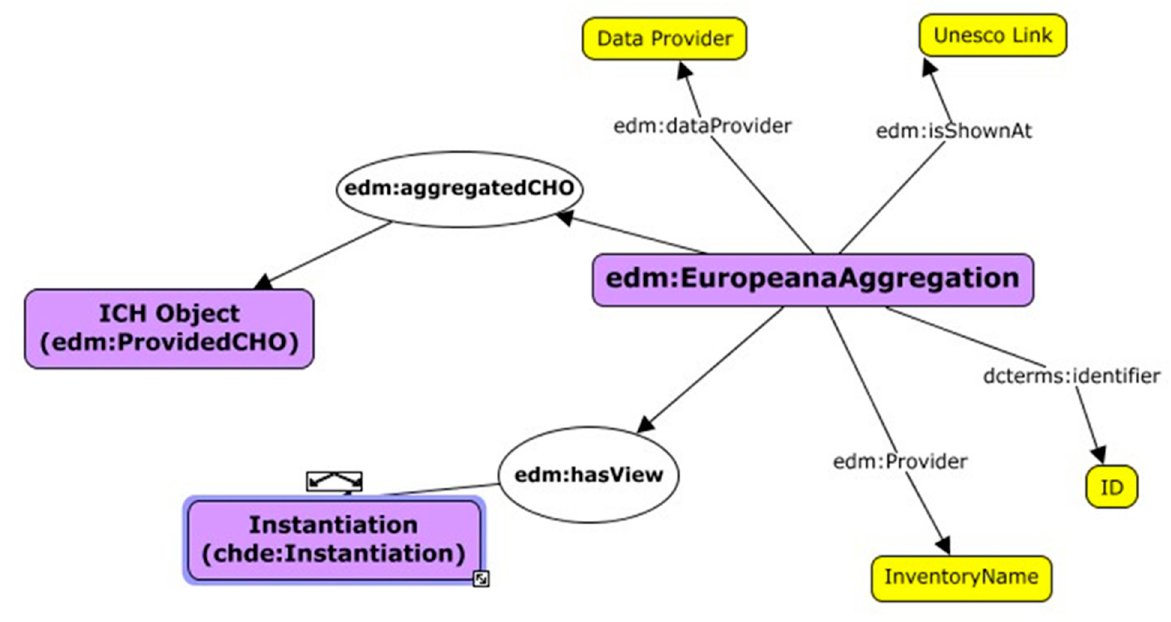
Figure 4. Main EDM instances.